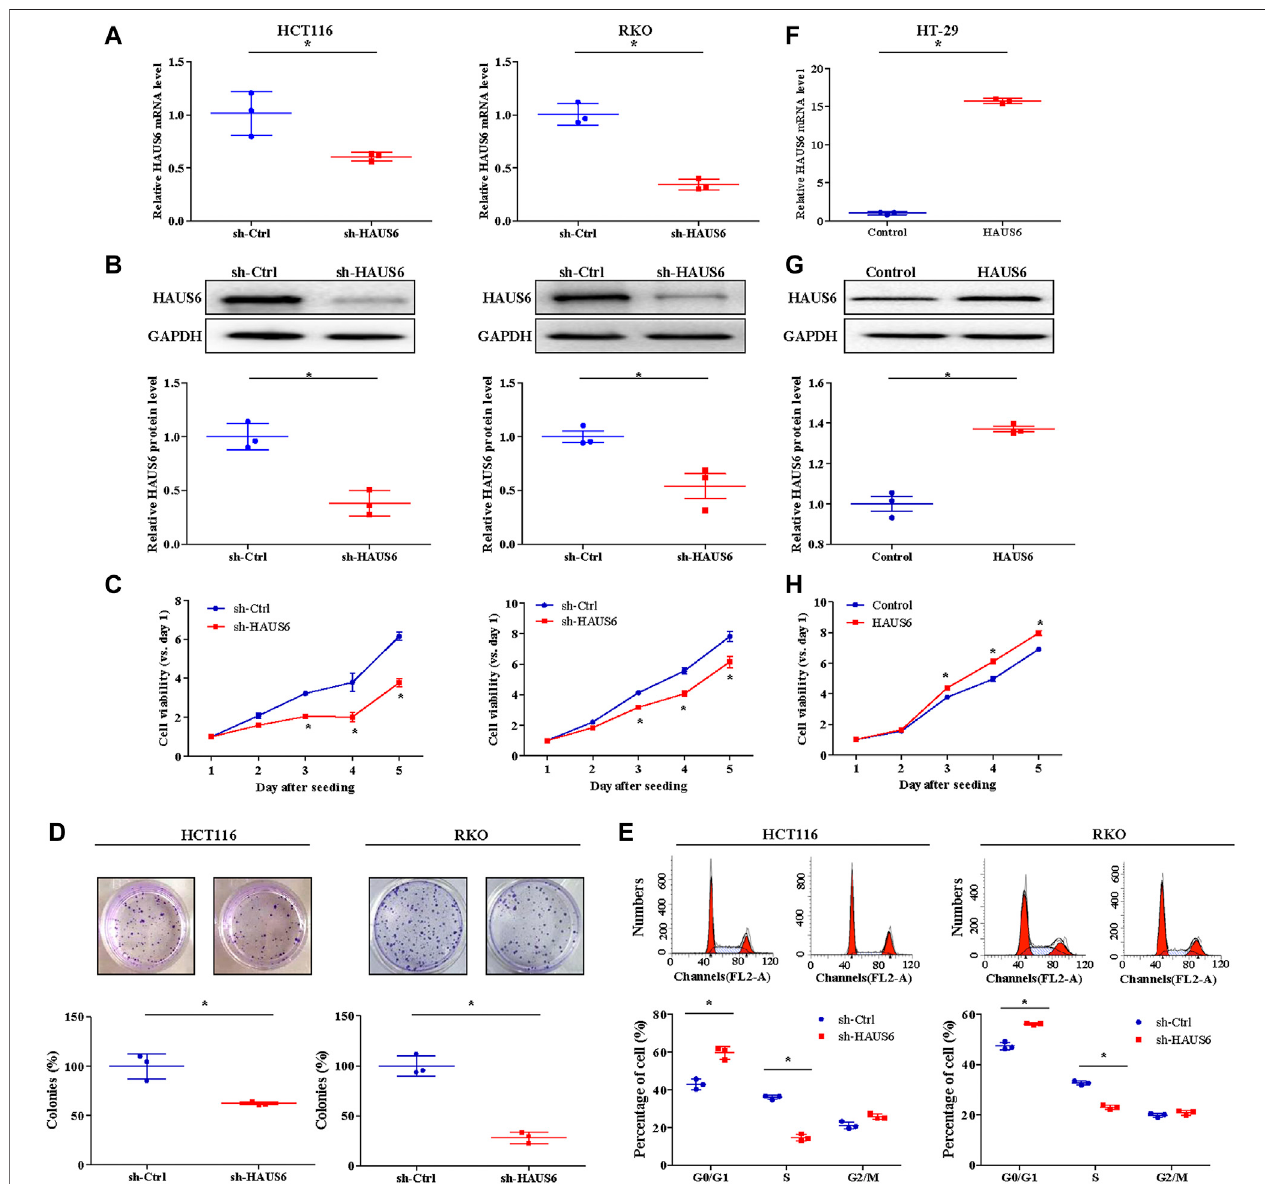
FIGURE3 | HAUS6 knockdown reduces CRC cell growth and proliferation invitro. (A) The mRNA and (B) protein levels ofHAUS6in HCT116 (left panel) and RKO (right panel) cells after transduction of sh-HAUS6 or sh-Ctrl were assessed by quantitative RT-PCR and western blotting (n (cid:1) 3). GAPDH was used as a loading control. Band intensities were quanti fi ed using ImageLab software. Mean ± SD; * p < 0.05, vs. sh-Ctrl, by independent Student ’ s t test. (C) Viability of HCT116 (left panel) and RKO(rightpanel)cellsafterknockdownofHAUS6wasdeterminedbyCCK-8assay.Dataarenormalizedtoviabilityonday1andarerepresented asfoldchanges. Mean ± SD; n (cid:1) 6; * p < 0.05, vs. sh-Ctrl, by independent Student ’ s t test. (D) Survival of HCT116 (left panel) and RKO (right panel) cells transduced with shRNA against HAUS6oracontrolshRNAwasassessed inthecolonyformationassay.Representativeimagesofcoloniesareshownabovethegraphs.Cellsurvivalwasnormalizedto thesh-Ctrlgroup.Mean ± SD;n (cid:1) 3;* p < 0.05,vs.sh-Ctrl,byindependentStudent ’ s t test. (E) PercentageofHCT116(leftpanel)andRKO(rightpanel)cellstransduced withshRNAagainstHAUS6oracontrolshRNAinG0/G1, S,and G2/Mphaseswasassessed by fl owcytometry.Representative fl owcytometryplotsareshownabove, and the percentages of cells in each phase are shown below. Mean ± SD; n (cid:1) 3; * p < 0.05, vs. sh-Ctrl, by independent Student ’ s t test. (F) The mRNA and (G) protein levels of HAUS6 in HT-29 cells after transduction of lentivirus encoding HAUS6 or Control plasmid were assessed by quantitative RT-PCR and western blotting (n (cid:1) 3). GAPDHwasusedasaloadingcontrol.Bandintensitieswerequanti fi edusingImageLabsoftware.Mean ± SD;* p < 0.05,vs.sh-Ctrl,byindependentStudent ’ s t test. (H) Viability of HT-29 cells after HAUS6 over-expression was determined by CCK-8 assay. Data are normalized to viability on day 1 and are represented as fold changes. Mean ± SD; n (cid:1) 6; * p < 0.05, vs. Control, by independent Student ’ s t test.